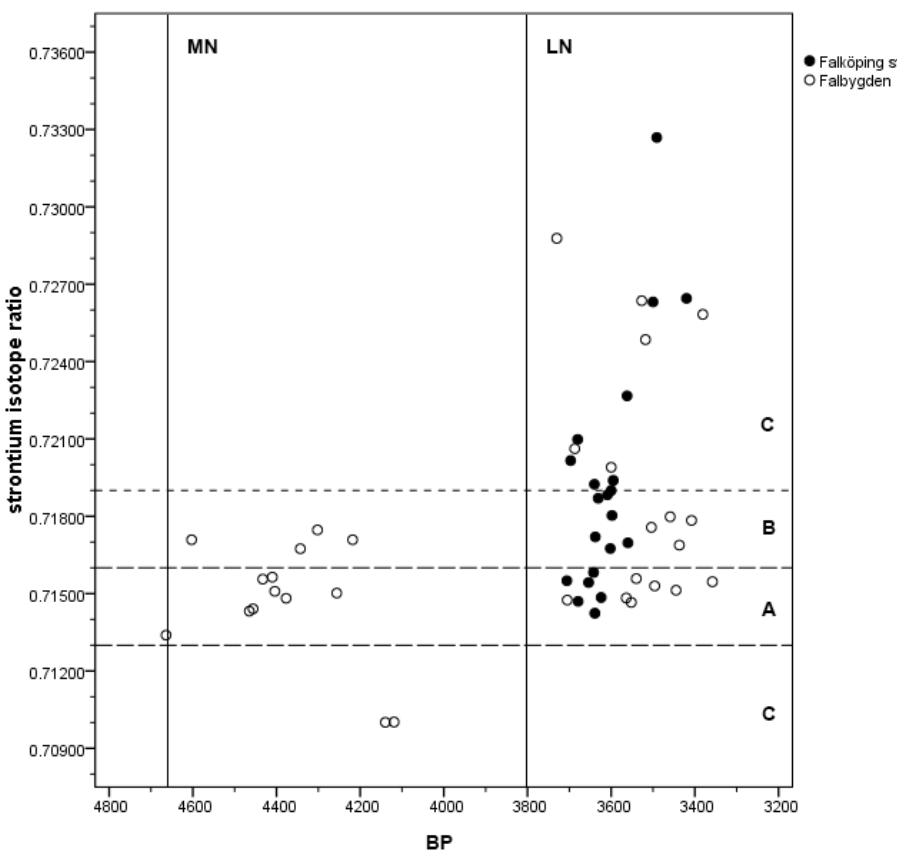
Figure 15. Scatterplot of strontium isotope ratios of individuals buried in megalithic graves in Falbygden, based on results from the current study and Blank and Knipper (in press). A: Local 87 Sr/ 86 Sr ratios, B: non-local/mixed 87 Sr/ 86 Sr ratios, C: non- local 87 Sr/ 86 Sr ratios, see text above. Lines mark periods: MN: Middle Neolithic and LN: Late Neolithic.